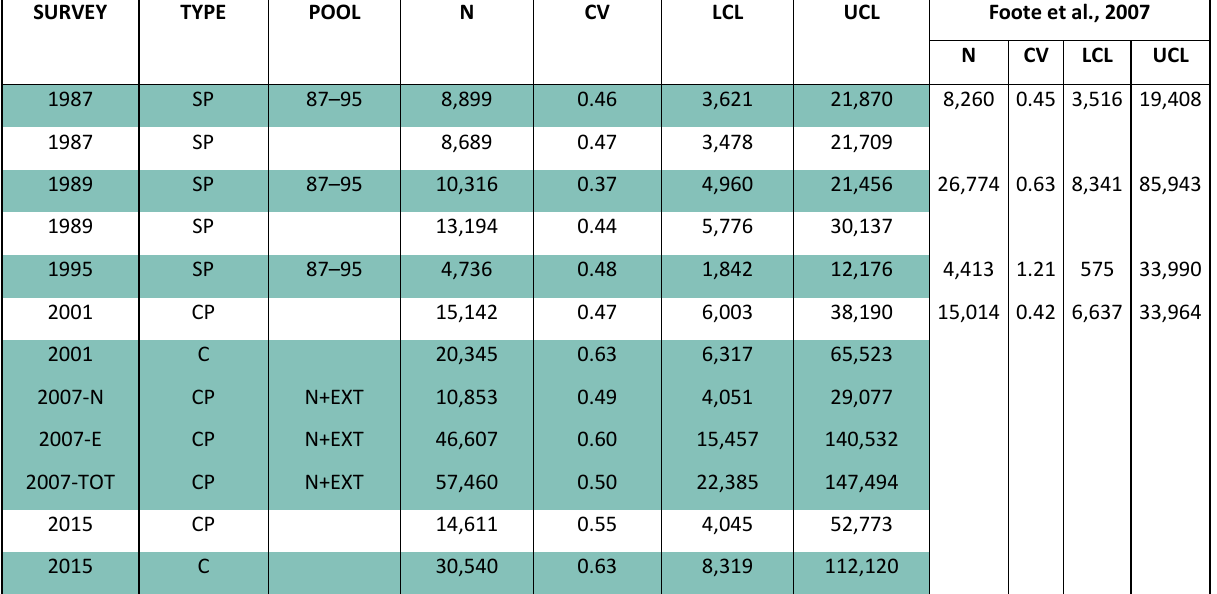
Table 3. Survey estimates for killer whales. Blue highlighted estimates are considered best. Estimates by Foote et al. (2007) are shown for comparison. SP - single platform; CP - combined platforms; C - corrected for perception bias; POOL - surveys pooled in detection function; N - NASS dedicated (2007); E - NASS extension